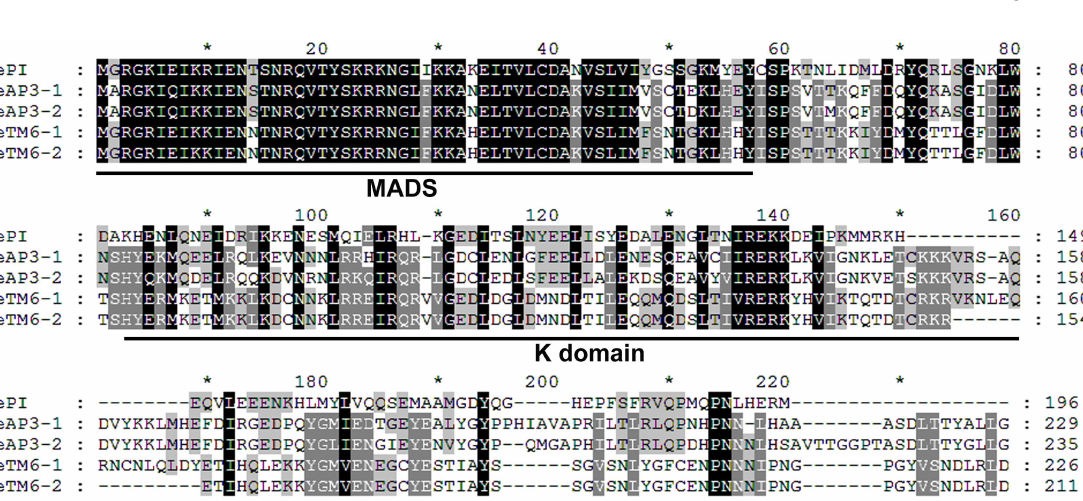
Fig 1. Comparison of the putative amino acid sequences of five MADS-box B class genes of T . erecta . The predicted amino acid sequencesdemonstrated that protein sequencesof all the isolated B class genesof T . erecta have the typical MIKC- type domain structure. The MADS and K domainsare indicatedby black